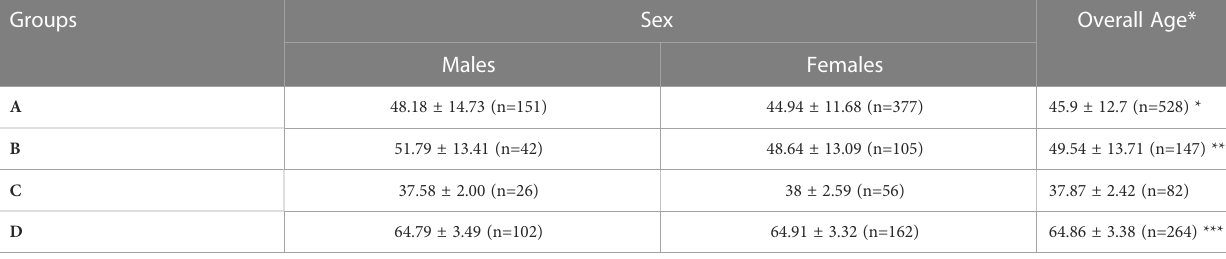
TABLE 2 Age and gender distribution among the different groups of vaccinated people.